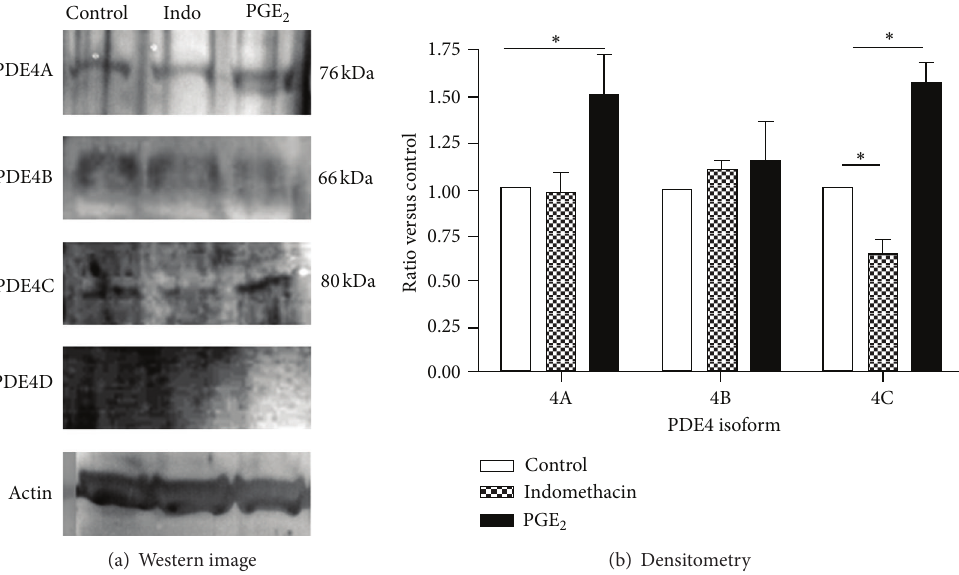
Figure 5: Effect of PGE 2 and indomethacin on PDE4 expression. Confluent HFL-1 cells were treated with SF-DMEM with or without 10 −9 M PGE 2 or 10 −6 M indomethacin for 24hrs. Whole cell lysates were immunoblotted for PDE4 isoforms and 𝛽 -actin as loading control. Images were visualized with ECL plus (a), and the bands from 3 separate experiments were quantified (b). ∗ 𝑃 < 0.05